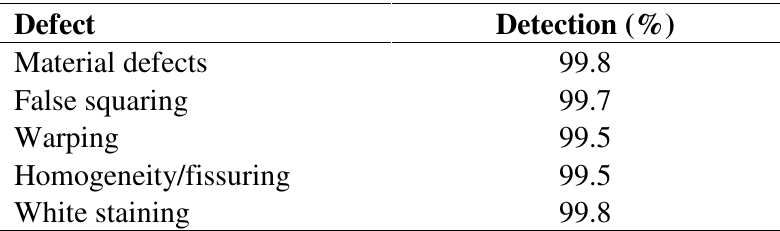
Table 4. Defects and detection